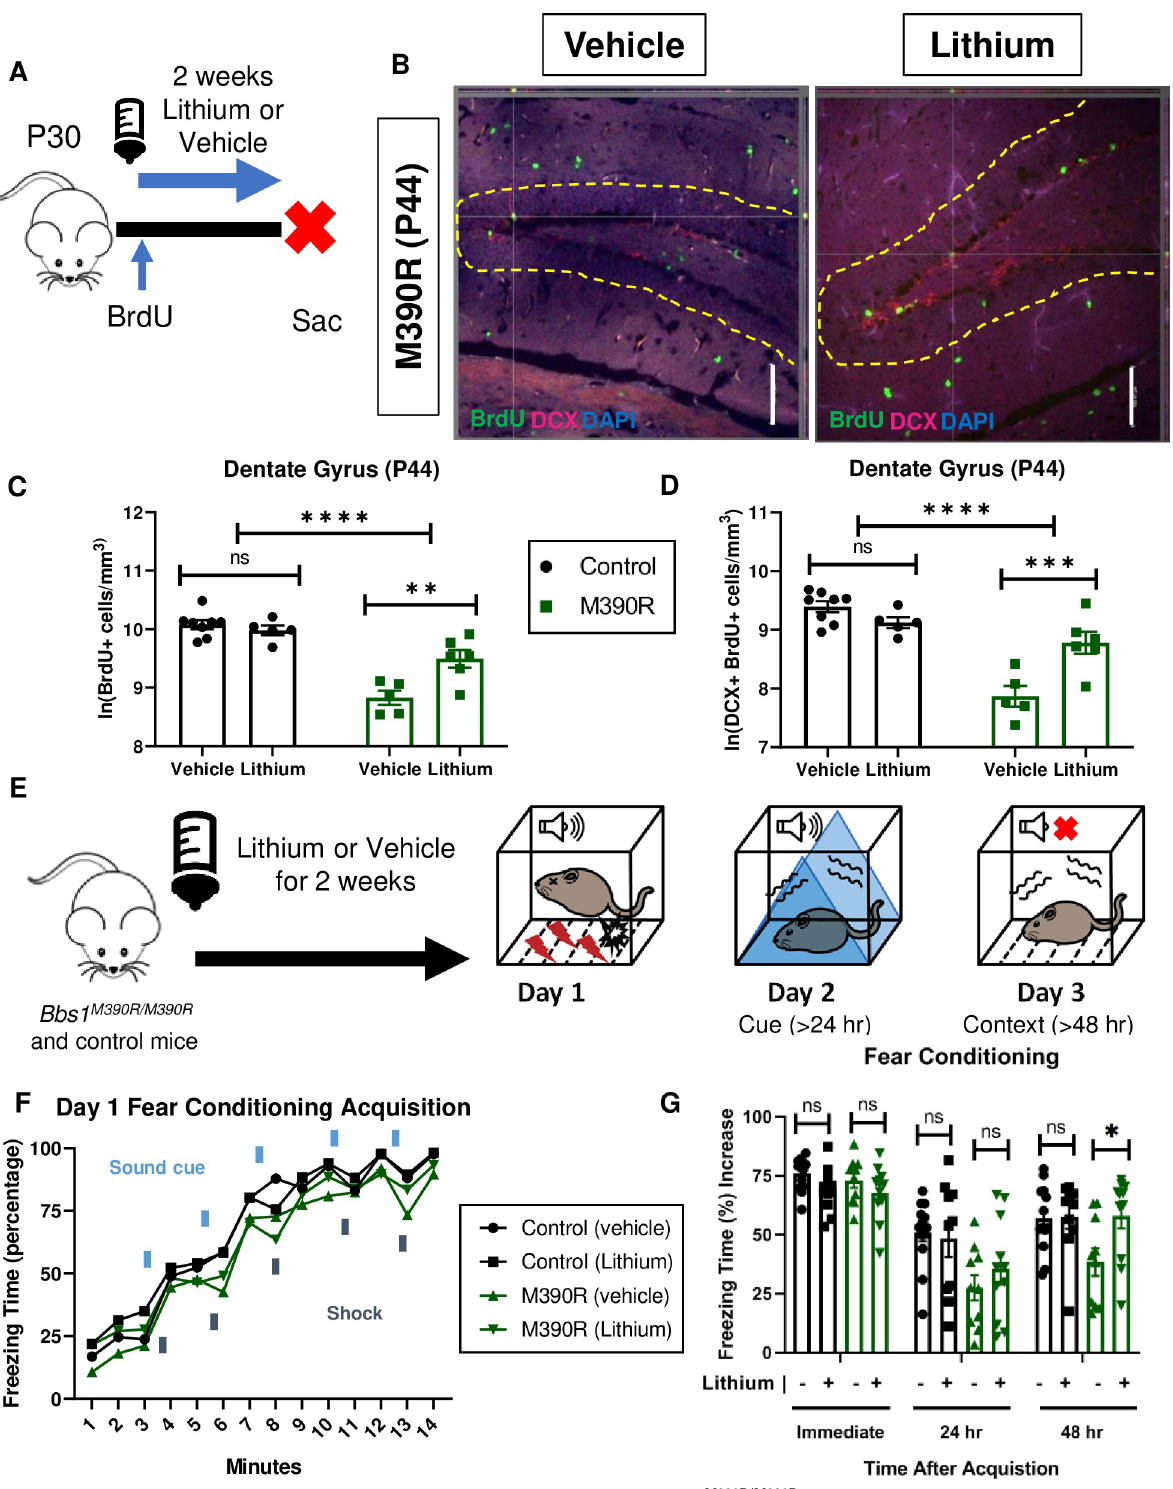
Fig 6. Chronic Lithium treatment rescued long-term context fear conditioning in Bbs1 M390R/M390R mice. A.) Schematic diagram of the Bromodeoxyuridine (BrdU) procedures for postnatal day 44 (P44) mice. At P30, mice were started on Lithium water (45mM) or continued with water (vehicle). Mice were also started on BrdU injections (2x50mg/kg) for five days. At P44, mice were taken down. Sac = Sacrifice. B.) Images of immunohistochemistry for neurogenesis of vehicle and lithium treated Bbs1 M390R/M390R mice. Z-stack, 20X, images of Dentate Gyrus at postnatal day